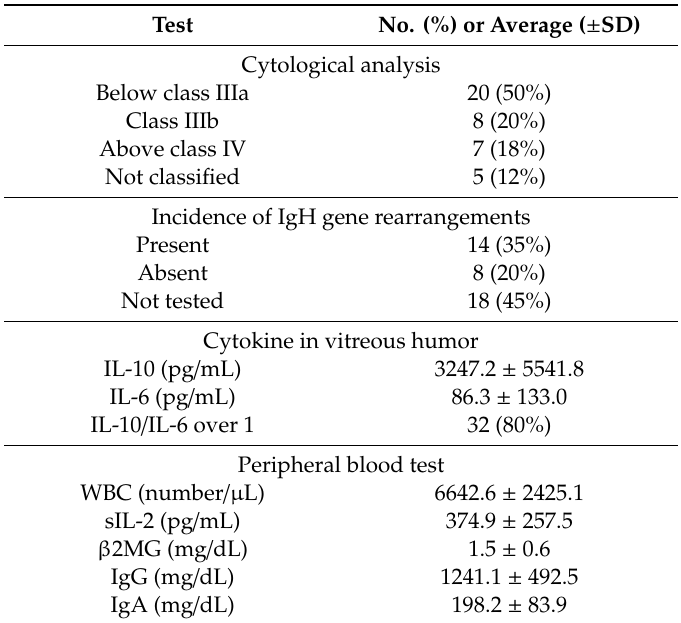
Table 2. Medical tests: cytological analysis and